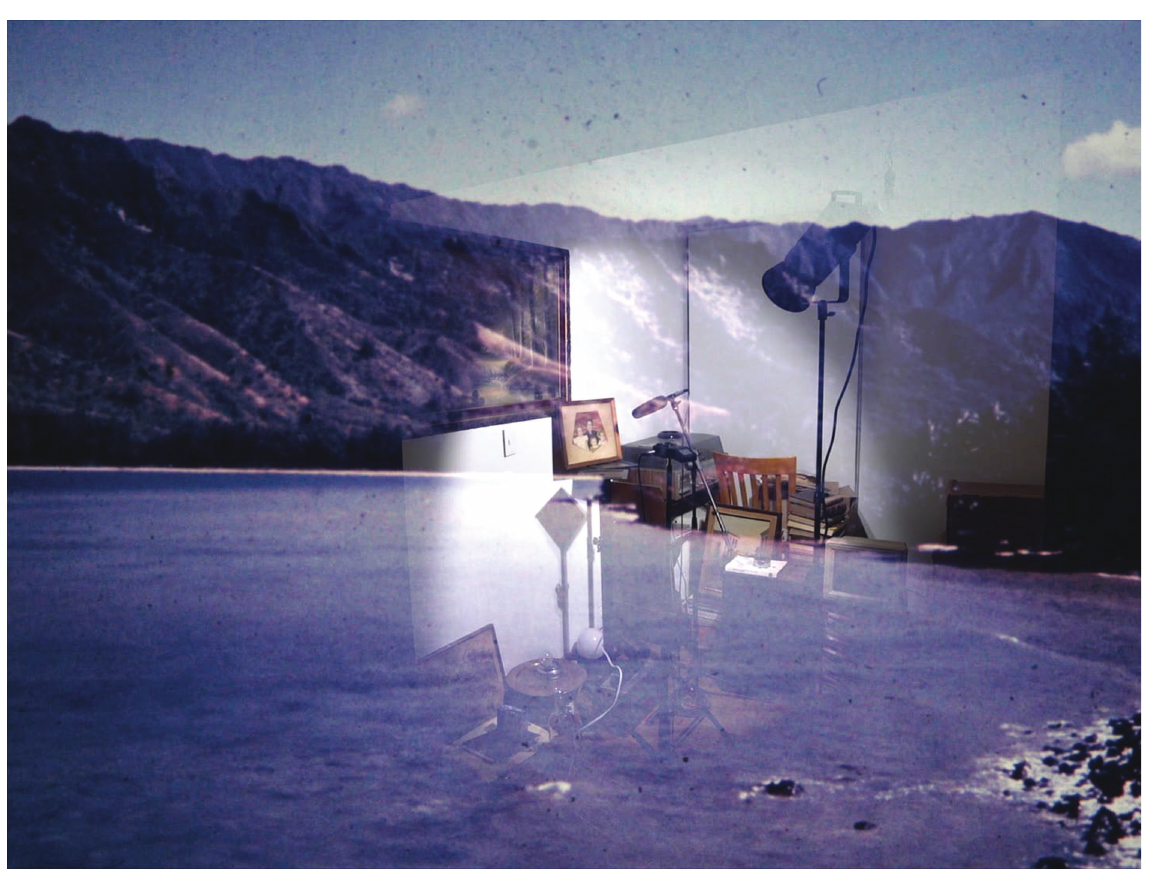
Figure 3. Still from To Remember: An exercise into the decolonisation of the filmmaker’s unconscious (Source: Emilio Reyes